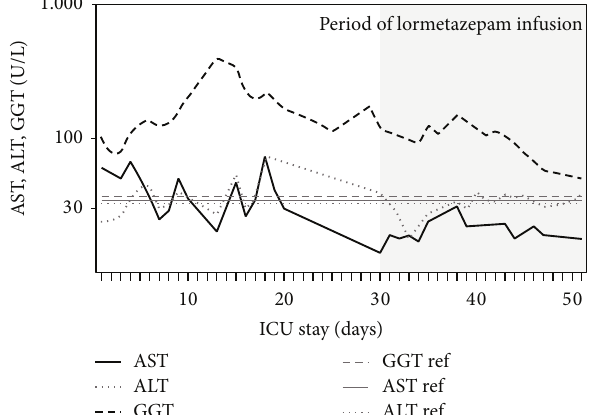
Figure 3: Blood concentrations of different liver enzymes during ICUtreatment.(AST,aspartatetransaminase;ALT,alaninetransam- inase; GGT, gamma-glutamyl transpeptidase). The grey lines (GGT ref, AST ref, and ALT ref) indicate the upper threshold levels for the corresponding enzymes; ref =